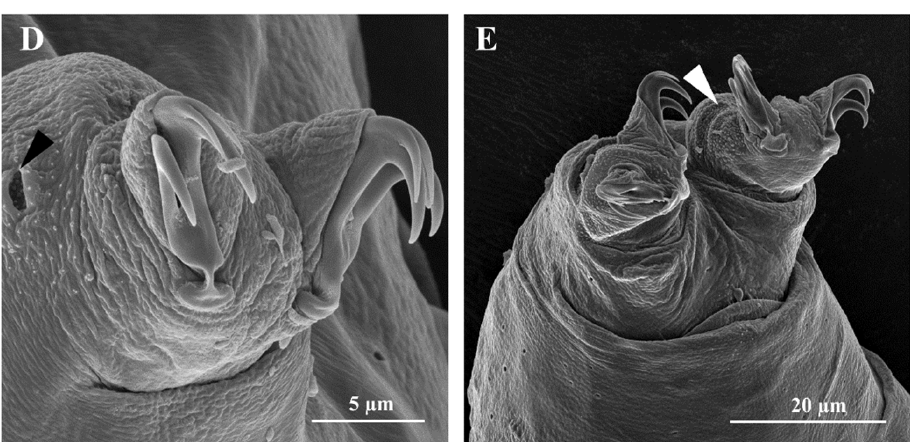
Figure 2. Macrobiotus kyoukenus sp. nov. ( A ) In toto specimen; ( B ) Desiccated in toto specimen; ( C ) Mouth opening with circum-oral sensory field (COS) (asterisk); ( D ) Claws of the second pair of legs with a pore showing an internal granulation (arrowhead); ( E ) Claws of the fourth pair of legs ornamented with a patch of fine cuticular granules (arrowhead). ( A – E ) SEM.